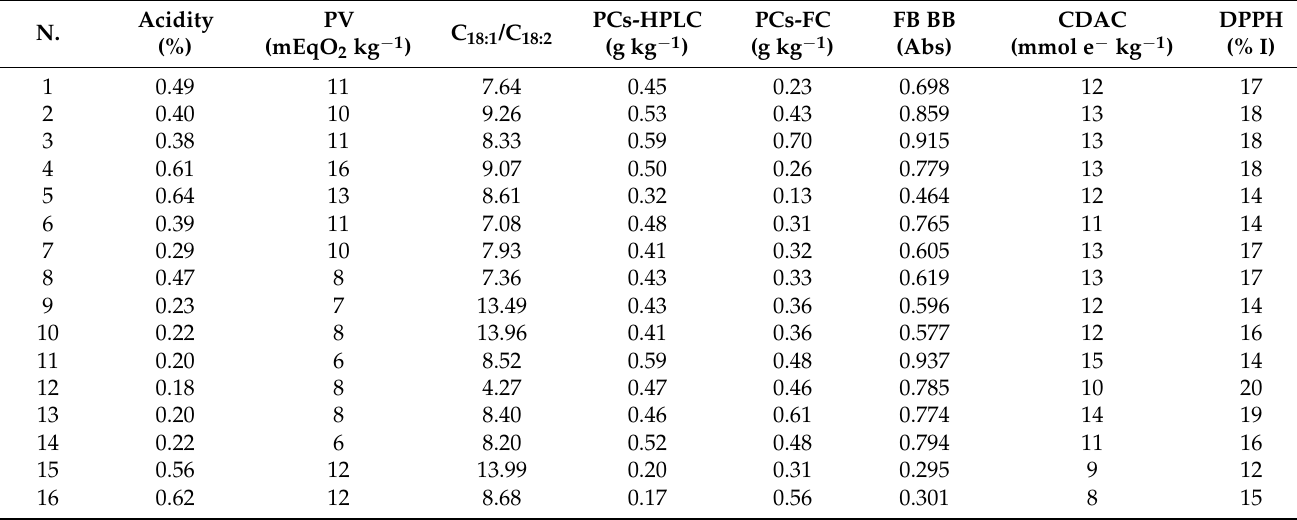
Table 1. Determination of free acidity (expressed as % oleic acid), peroxide values (PV), C 18:1 /C 18:2 ratio, total phenolics by HPLC (PCs-HPLC) and Folin–Ciocalteu (PCs-FC) methods, Fast Blue BB (FBBB), coulometrically determined antioxidant capacity (CDAC) and DPPH radical scavenging activity (% I) for the EVOO samples evaluated in this study. Measured values are average of at least three replicate analyses. In all cases relative standard deviation was lower than